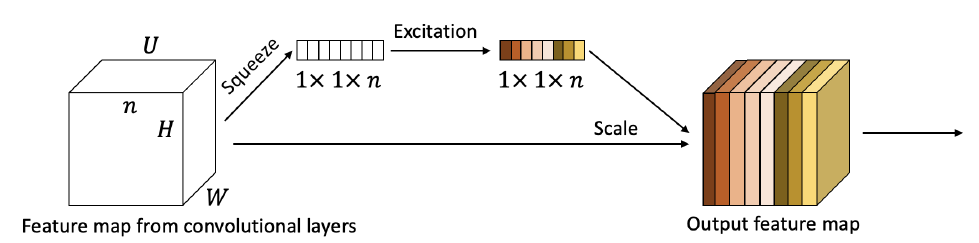
Figure 3. Illustration of the channel-wise attention mechanism structure. The channel-wise attention is added at the end of each convolutional block, which models the interdependencies among the channel features of the convolutional